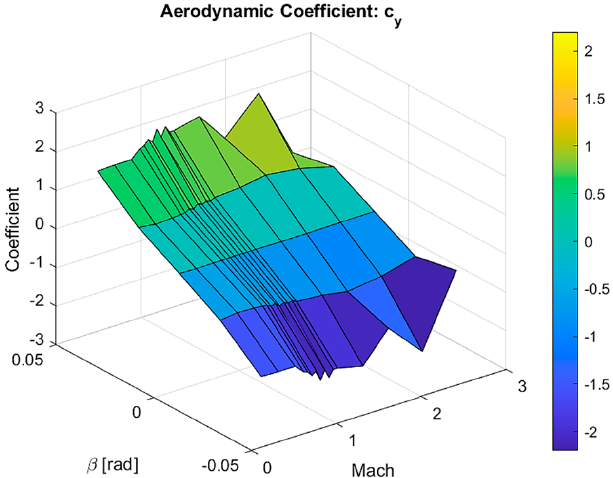
Figure 17. Side force coefficient as derived from the sideslip angle and Mach number.